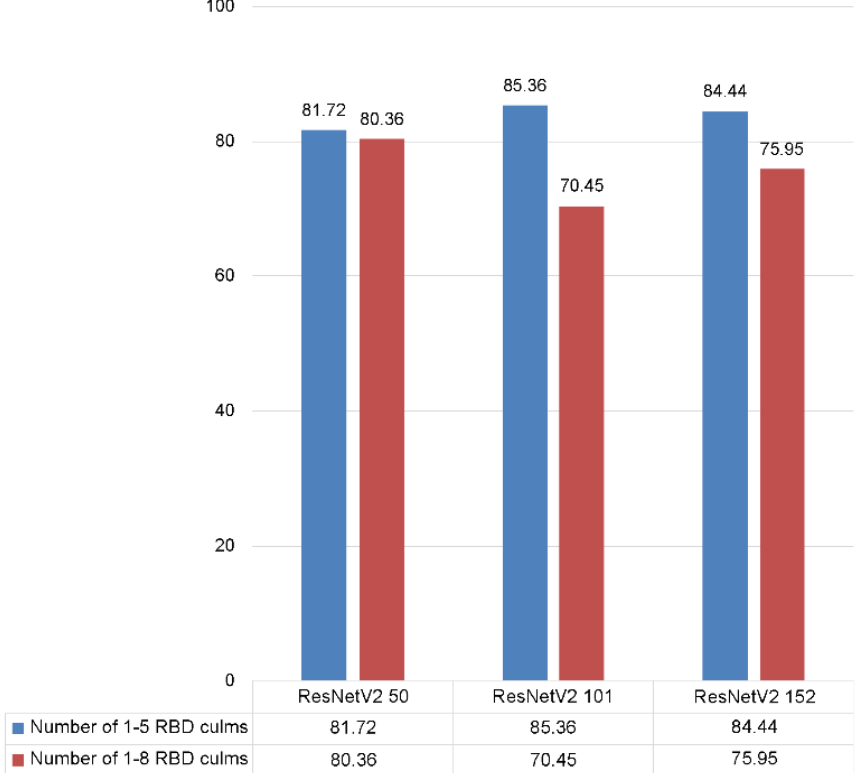
Figure 23. The comparison of classification performance for RBD infected culm data.